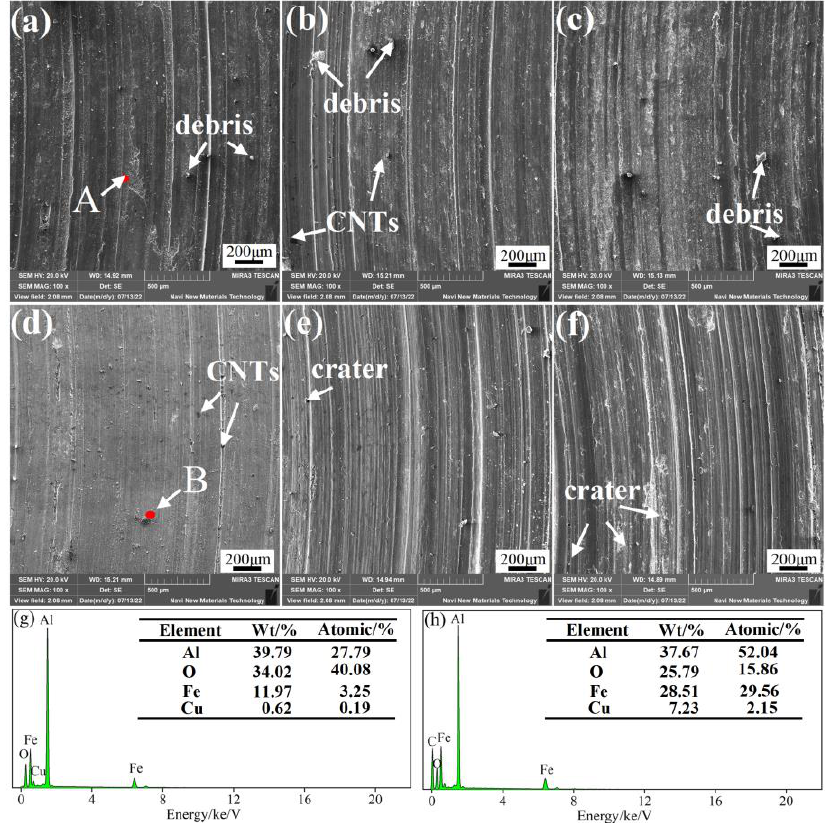
Figure 12. SEM micrographs and EDS of representative worn surfaces of x % CNTs/Al-Cu-Mg-Si: ( a ) 0 wt%, ( b ) 0.5 wt%, ( c ) 1.0 wt%, ( d ) 1.5 wt%, ( e ) 2.0 wt%, ( f ) 3.0 wt%, ( g ) EDS result of point A,